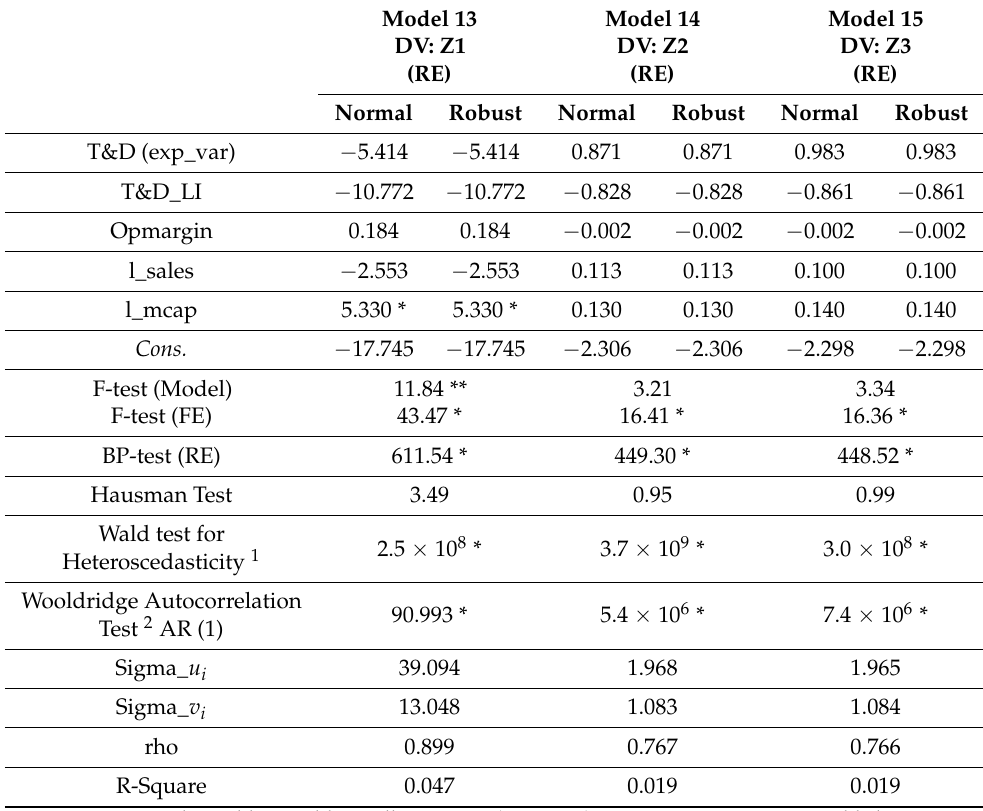
Table 8. Interaction Models (Static Panel Data Analysis).